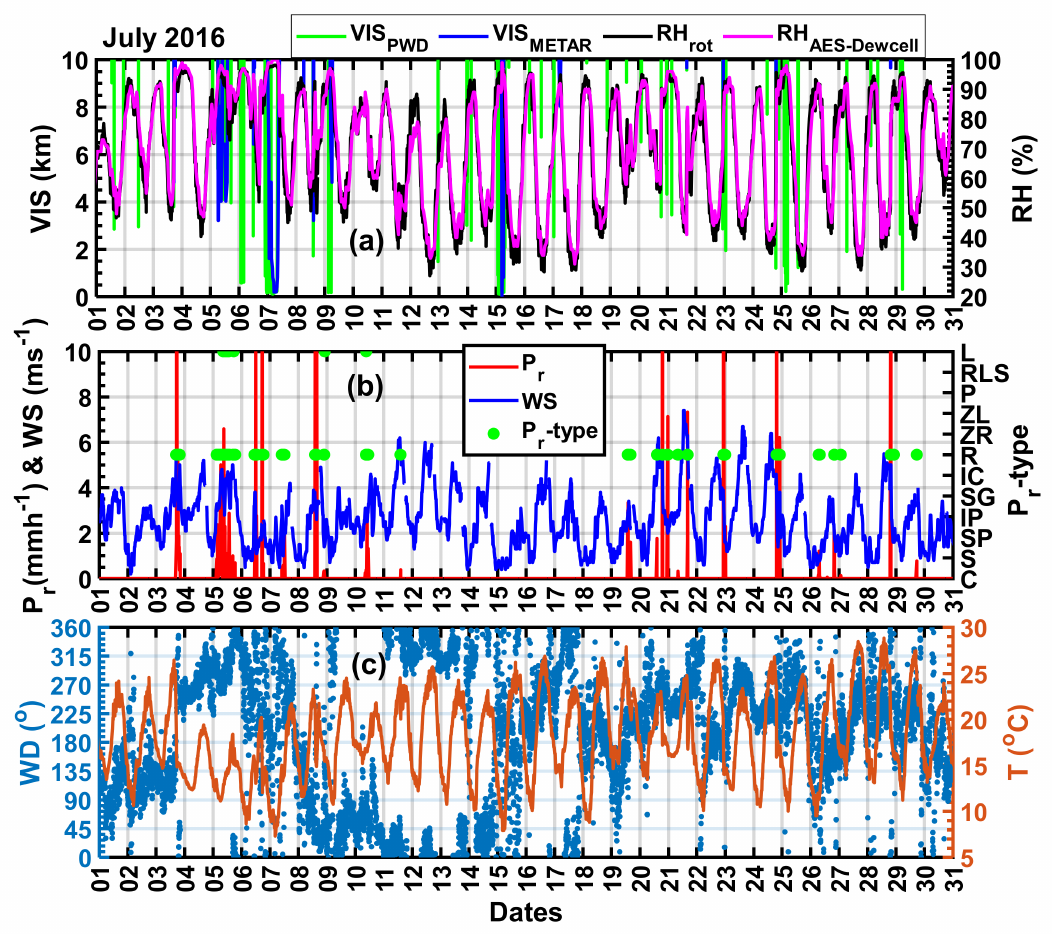
Figure 5. The same as Figure 4, but for the July